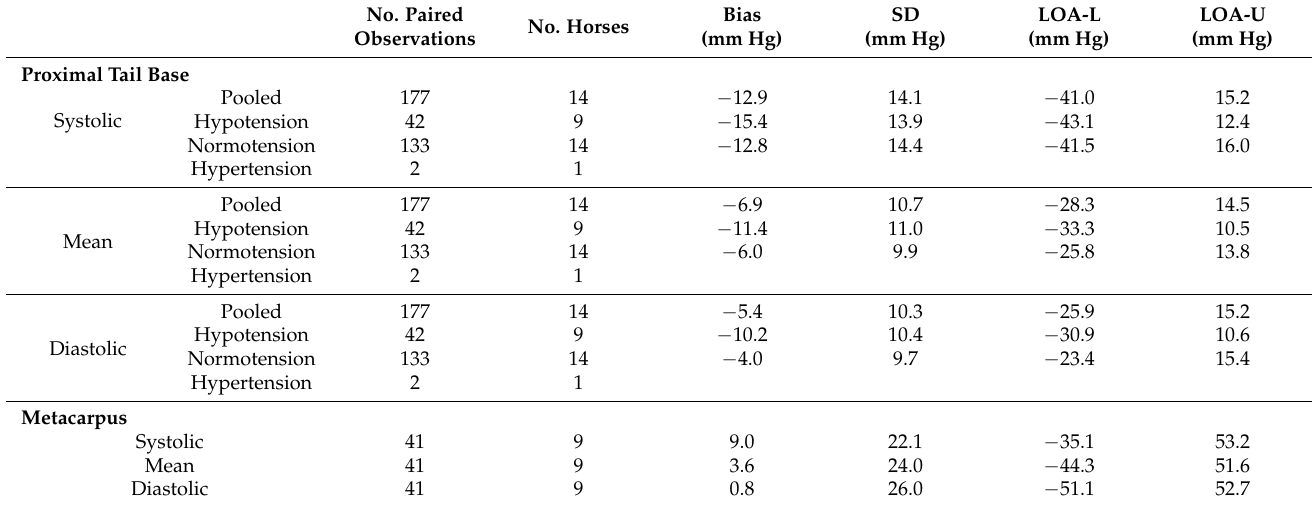
Table 2. Bland–Altmann analyses for 218 paired arterial blood pressure measurements made non-invasively compared to those made invasively using the Bionet BM7Vet in 14 healthy, anaesthetised horses.